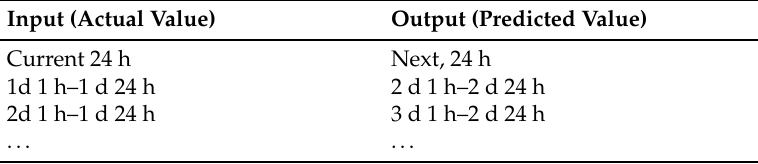
Table 3. Dataset Statistics, where h is hour, d is